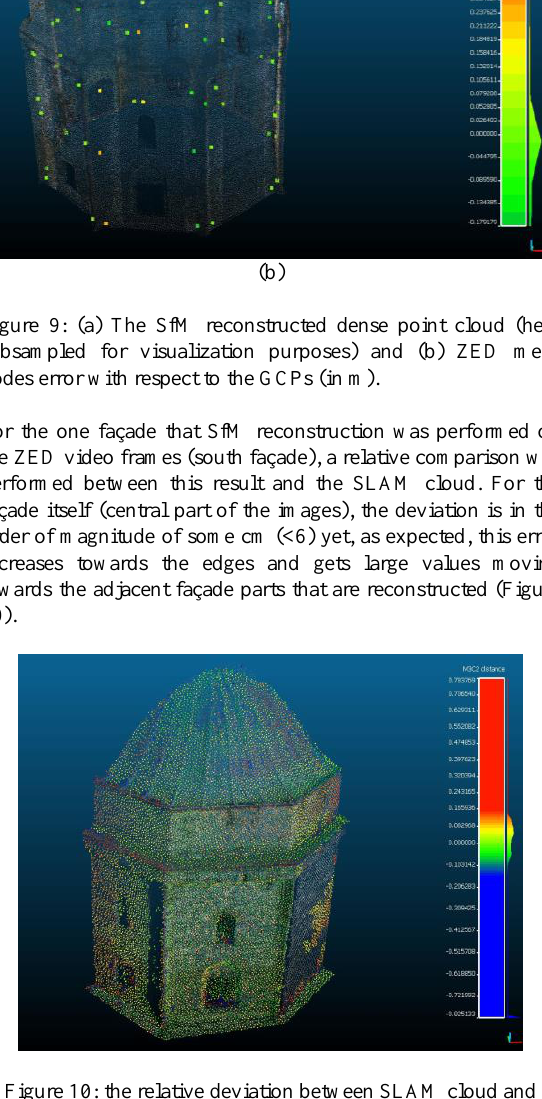
Figure 10: the relative deviation between SLAM cloud and SfM/MVS cloud generated using the ZED